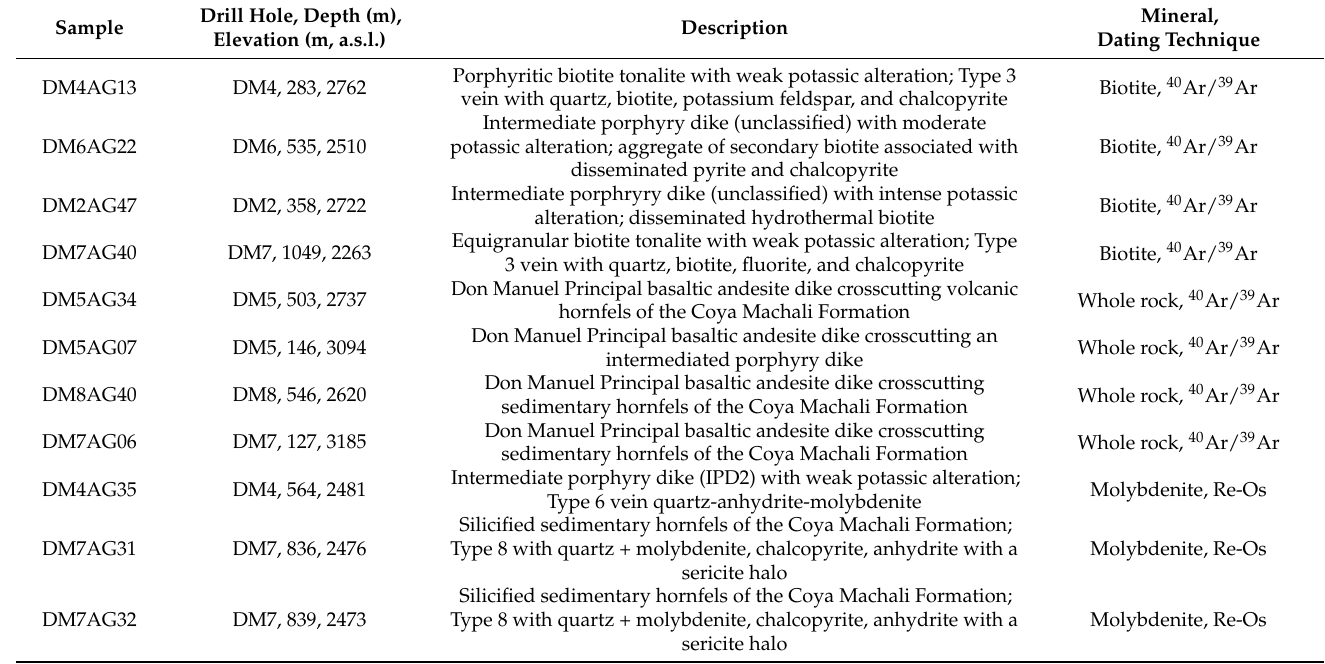
Table 3. Sample locations and descriptions for 40 Ar/ 39 Ar and Re-Os geochronology.